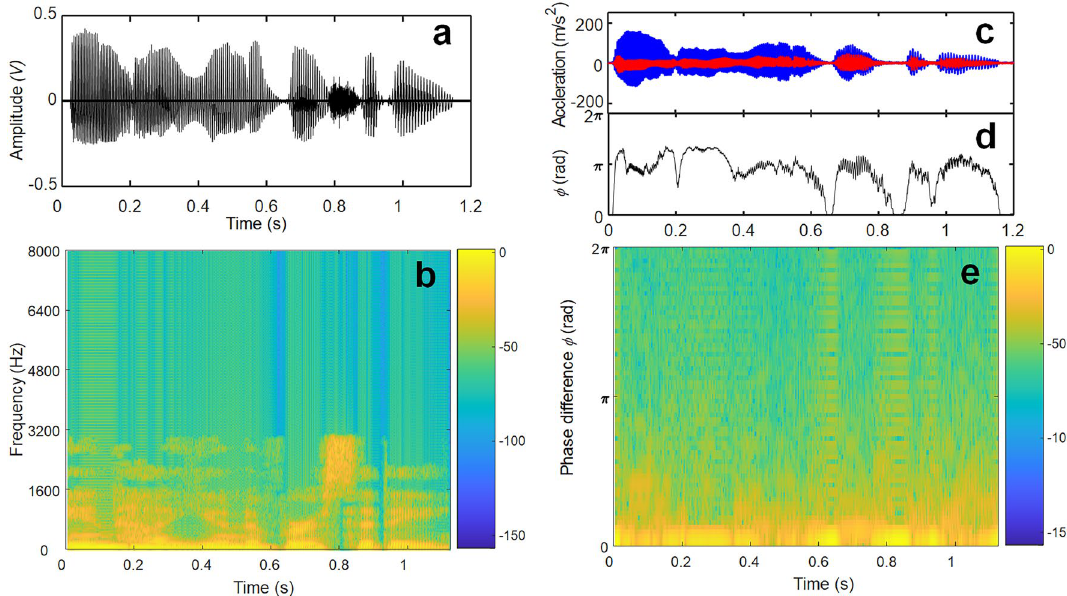
Figure 6. Comparison between STFT and HT (Inha university). ( a ) Speech signal, ( b ) its spectrogram, ( c ) two acceleration signals, ( d ) their phase difference, ( e ) corresponding new spectrogram (time vs. phase difference obtained by